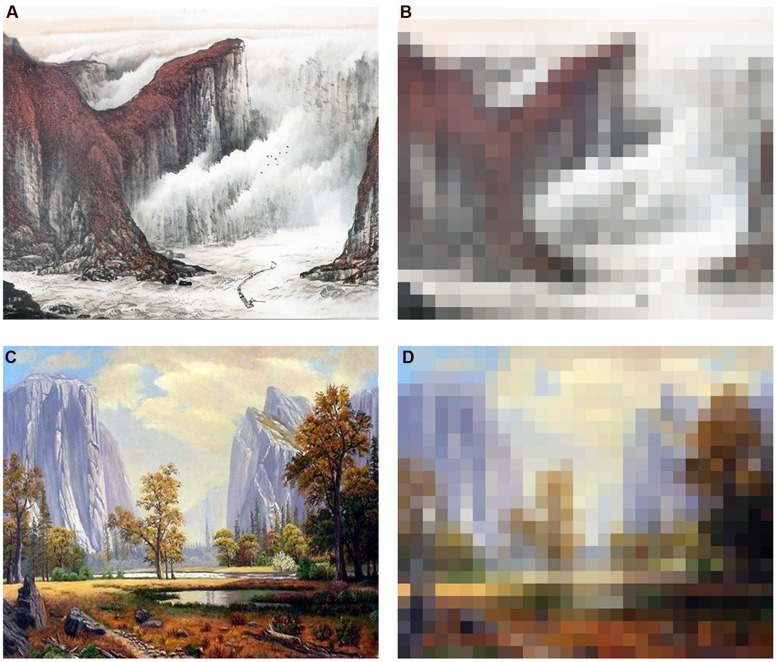
Examples of the four types of paintings used. (A) An example of an original traditional Chinese landscape painting; (B) An example of a scrambled traditional Chinese landscape painting; (C) An example of an original realistic oil landscape painting; (D) An example of a scrambled realistic oil landscape painting.